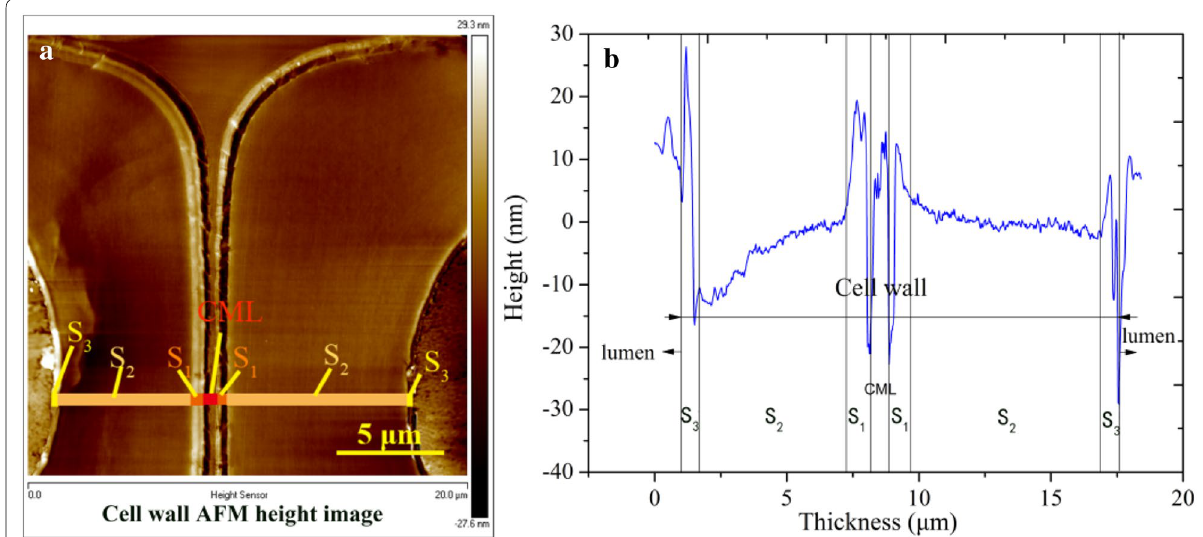
Fig. 2 Geometrical parameters of cell wall measurement via AFM. a Cell wall AFM height image; b height distributions along two adjacent cell